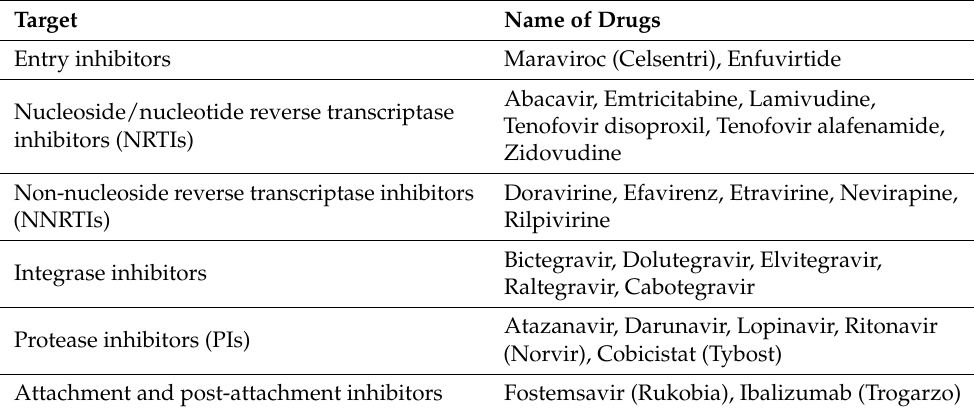
Table 2. Showing the different classes of cART drugs currently in use for the treatment of HIV